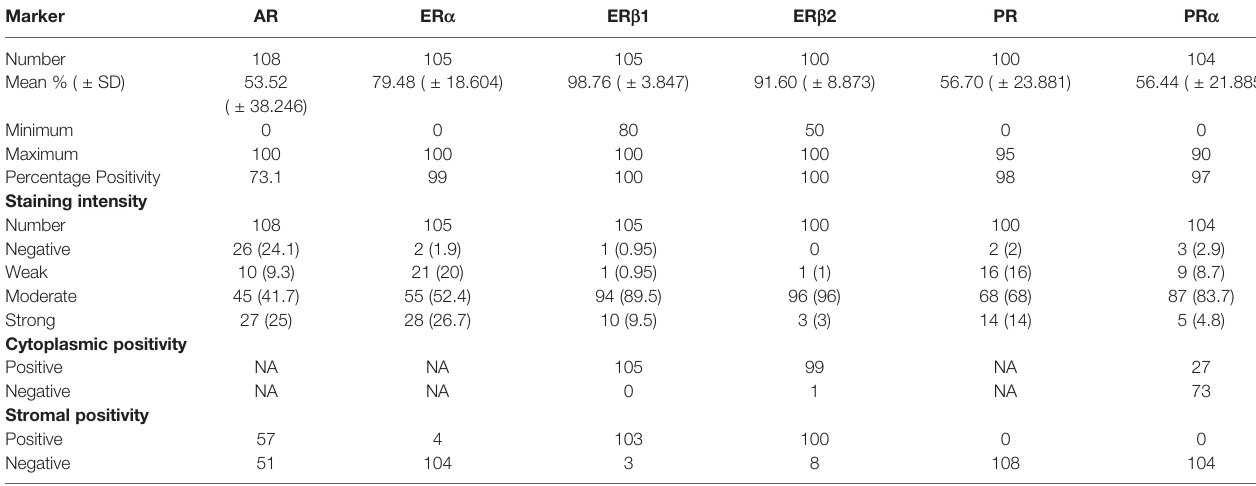
TABLE 2 | Details of immunohistochemical expression of the studied markers in gynaecomastia lesions.